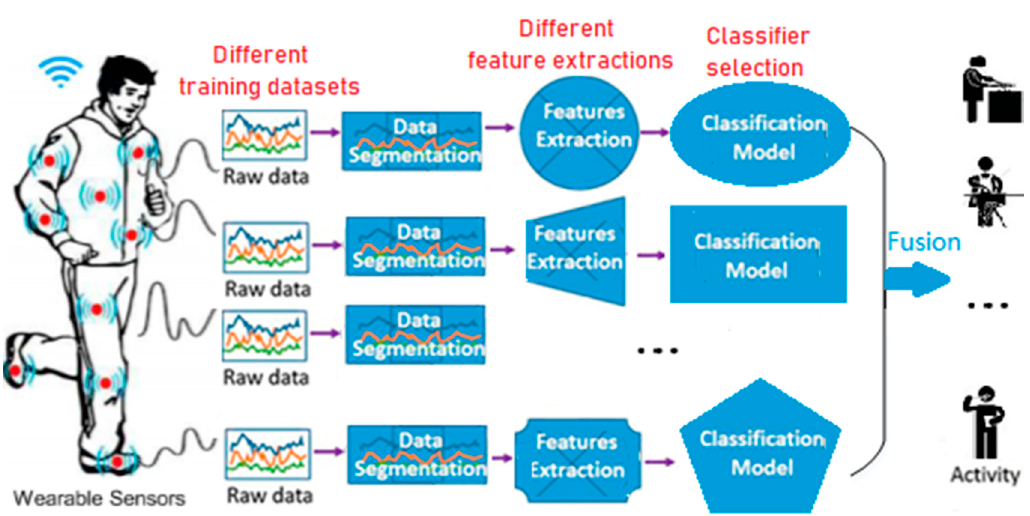
Figure 2. The structure of multi ‐ sensor fusion with an ensemble learning system.